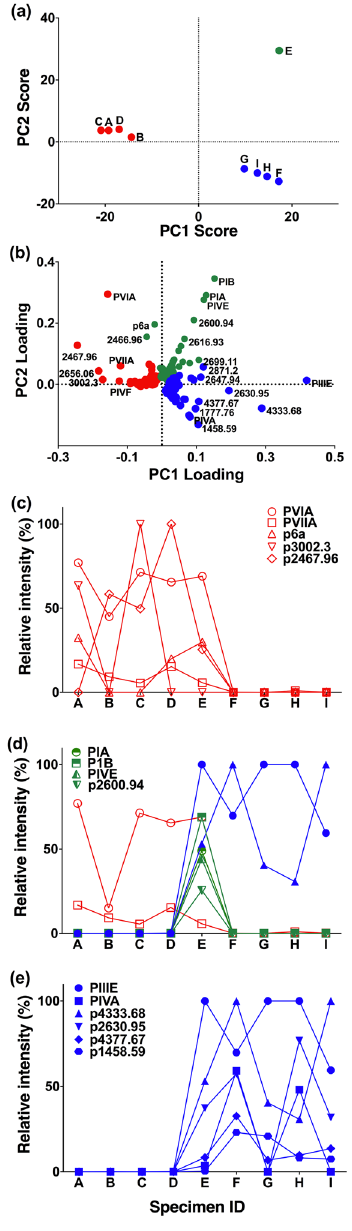
Figure 2. Clustering pattern of nine C. purpurascens specimens and grouping of the peptides in each cluster. ( a ) Scores plot generated in the PCA analysis of the LC-ESI Triple TOF-MS data of each predatory venom. The specimens with similar venom profiles are clustered together while different ones are well separated. (Scores for PC1 79.9% Vs PC2 14.6%, Pareto Scaling). ( b ) The Loading plot shows contribution of 1000 peptides shared across 9 specimens to the venom variability among the clusters. The expression patterns of the dominant unique peptides grouped into each group; group 1 ( c ), 2 ( d ) and the hybrid of group 1 and 2 ( e